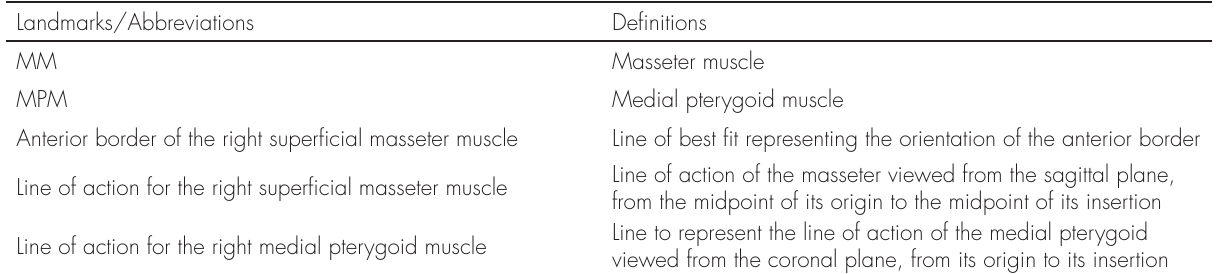
Table II. Muscle border planes and lines of action used to assess the topography of the right masseter and medial pterygoid